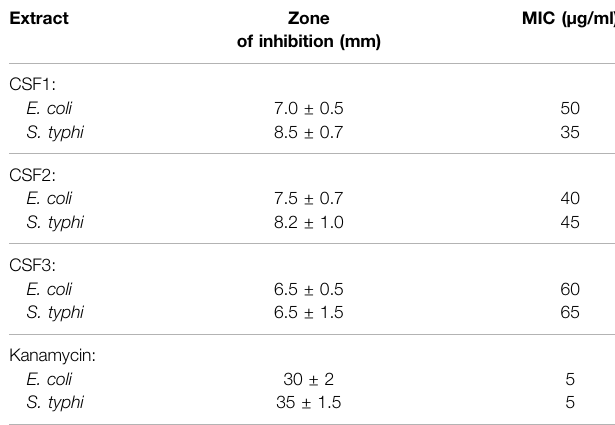
TABLE 4 | Inhibitory action of Cordyceps sinensis supercritical carbon dioxide extracts on bacterial pathogens, Escherichia coli and Salmonella typhi